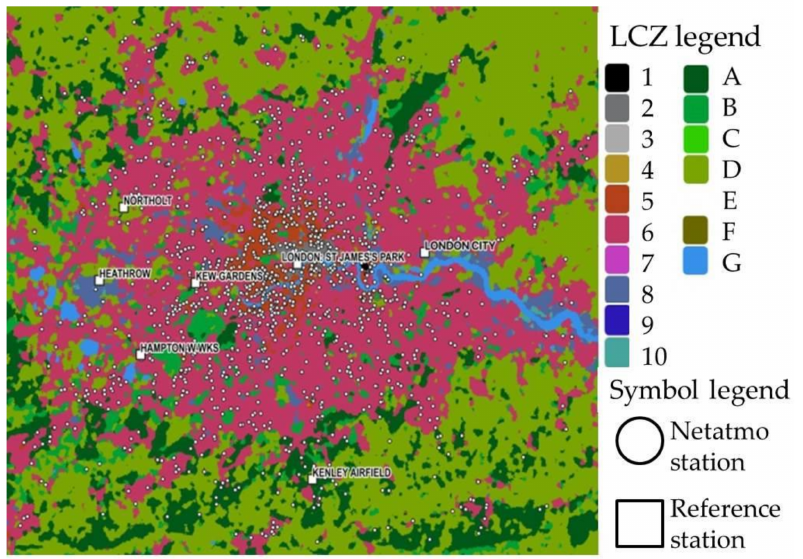
Figure 2. The LCZ map of London with positions of all Netatmo stations (white circles) from which data was collected throughout this study. Labeled reference stations are also indicated by white